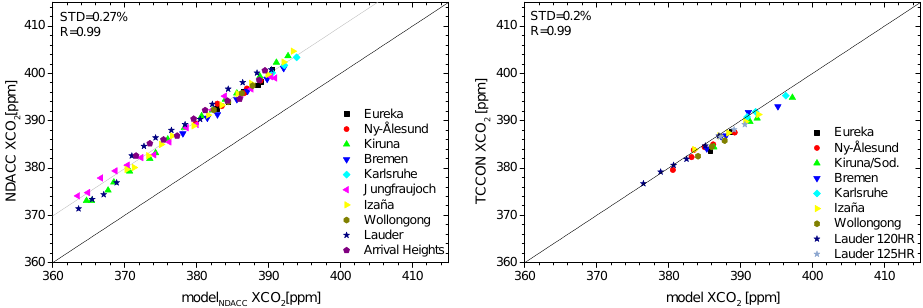
Figure 9. Correlations of the yearly means. Left: NDACC vs. model NDACC (1996–2012), right: TCCON vs. model (2005–2012). Fig. 9. Correlations of the yearly means. Left: NDACC vs. model NDACC (1996-2012), right: TCCON vs. model (2005-2012).